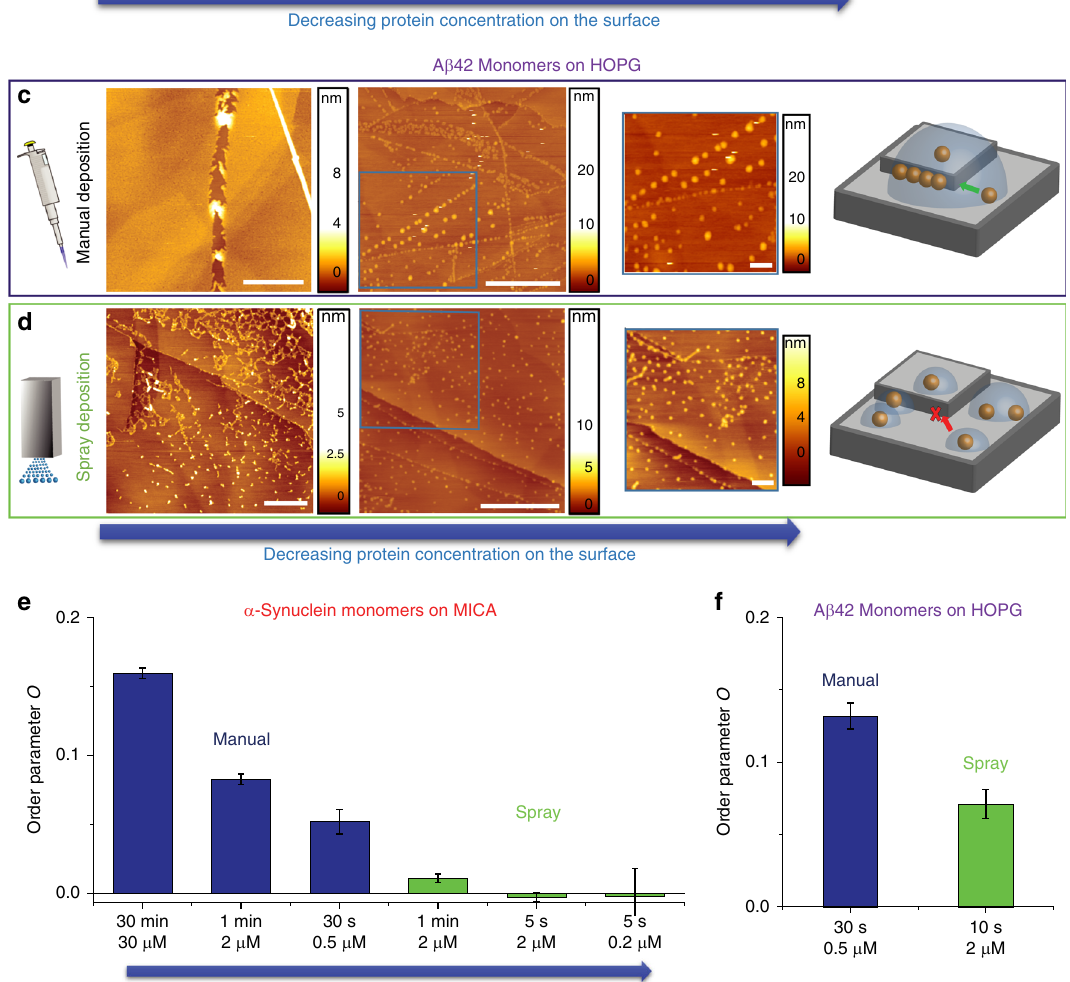
Fig. 3 Rapid drying by the micro fl uidic spray technique avoids surface self-organization. Deposition of α -synuclein monomers on a mica surface by ( a ) manual preparation at decreasing protein concentration of deposition on the surface: 30 μ M and 30 min, 2 μ M and 1 min, 0.5 μ M and 30 s (scale bars 100 nm); ( b ) micro fl uidic spray of a 2 μ M solution for 1 min (scale bar 100 nm) and 5 s, 0.2 μ M for 5 s (scale bars 100 nm). Deposition of A β 42 monomers on a HOPG surface by ( c ) manual preparation at decreasing protein concentration on the surface: 2 μ M and 1 min (scale bar 500 nm) and 0.5 μ M and 30 s (scale bar 1 μ m); ( d ) micro fl uidic spray of a 2 μ M solution for times of 1 min (scale bar 500 nm) and 10 s (scale bar 1 μ m). On the right side of each panel, a detail of the AFM maps (scale bar 100 nm) and illustrations of the allowed diffusional processes of individual monomers are presented. Quanti fi cation of the degree of ordering, through the order parameter O, in each AFM map for ( e ) α -synuclein and ( f ) A β 42 (values are mean ± s.d.)